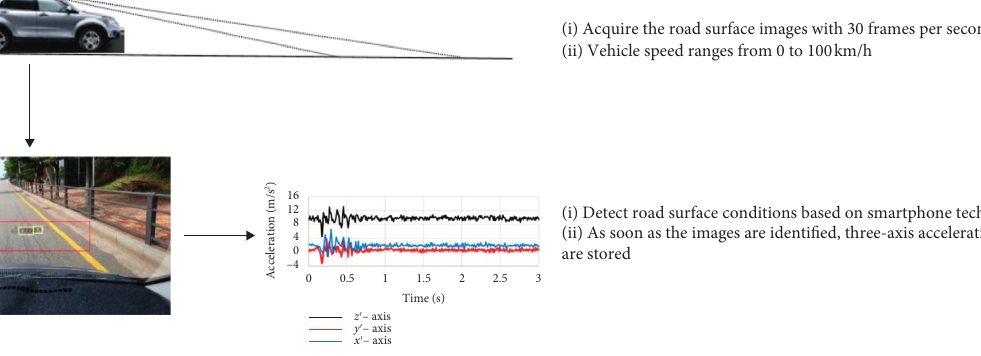
Figure 1: Overall flow of image and three-axis acceleration data acquisition using a smartphone camera.